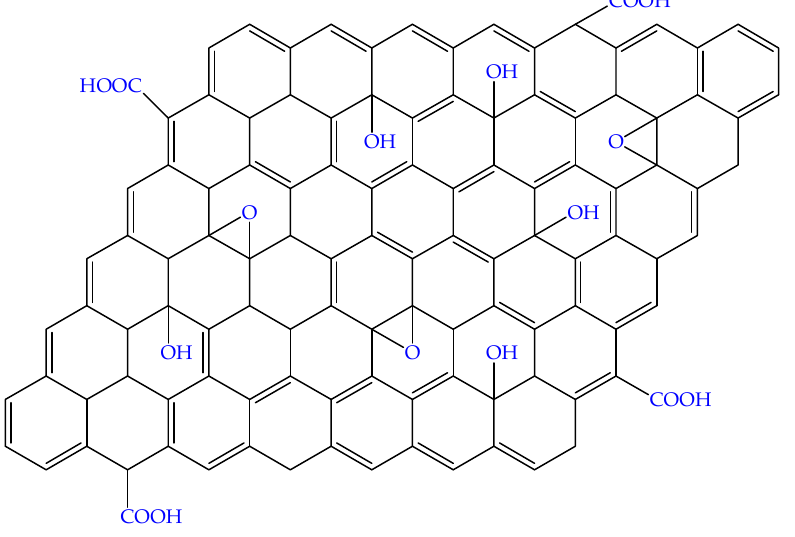
Figure 1. Chemical structure of graphene oxide.